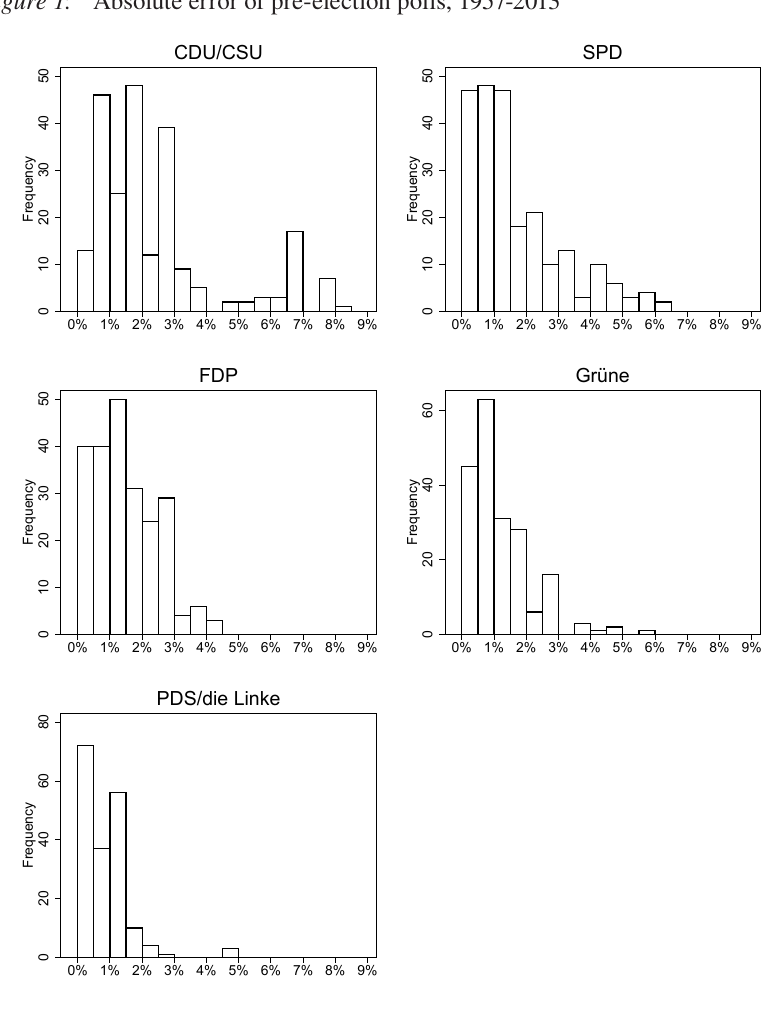
Figure 1 : Absolute error of pre-election polls,